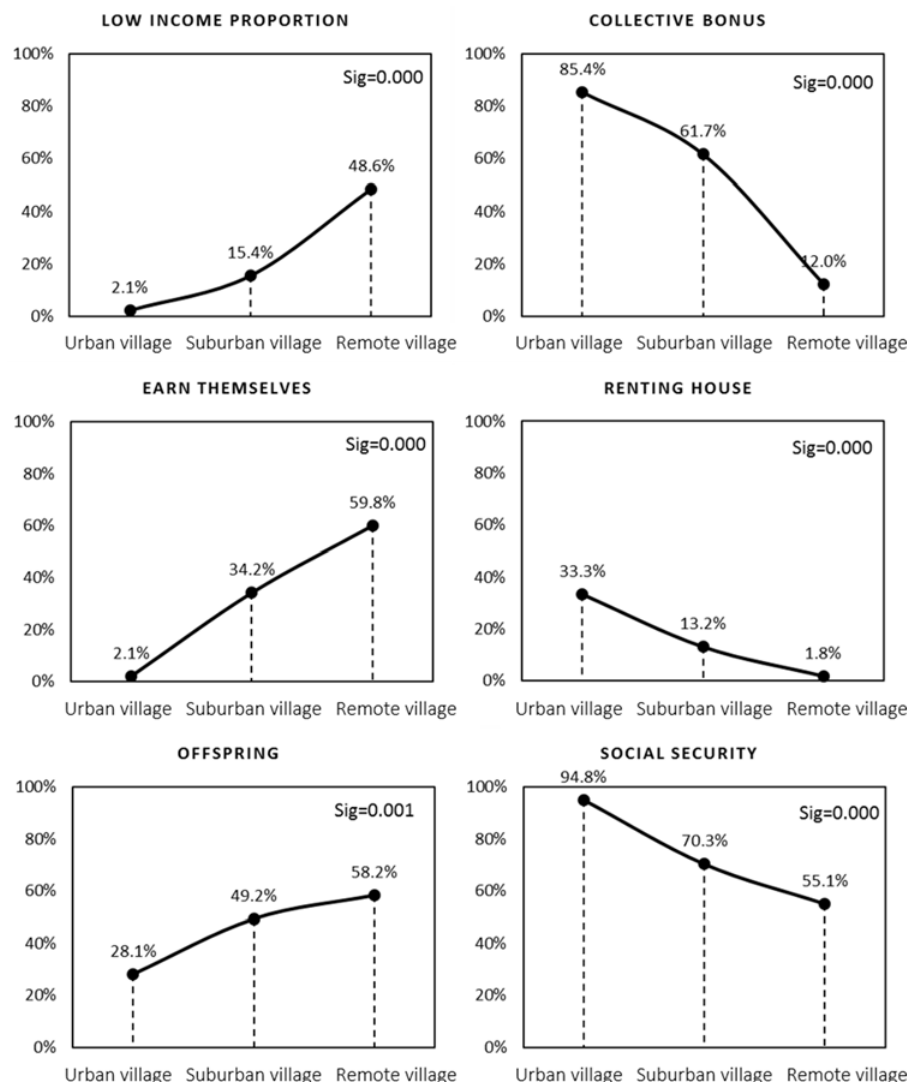
Figure 2. ( a – f ) Income features of the respondents in rural villages.